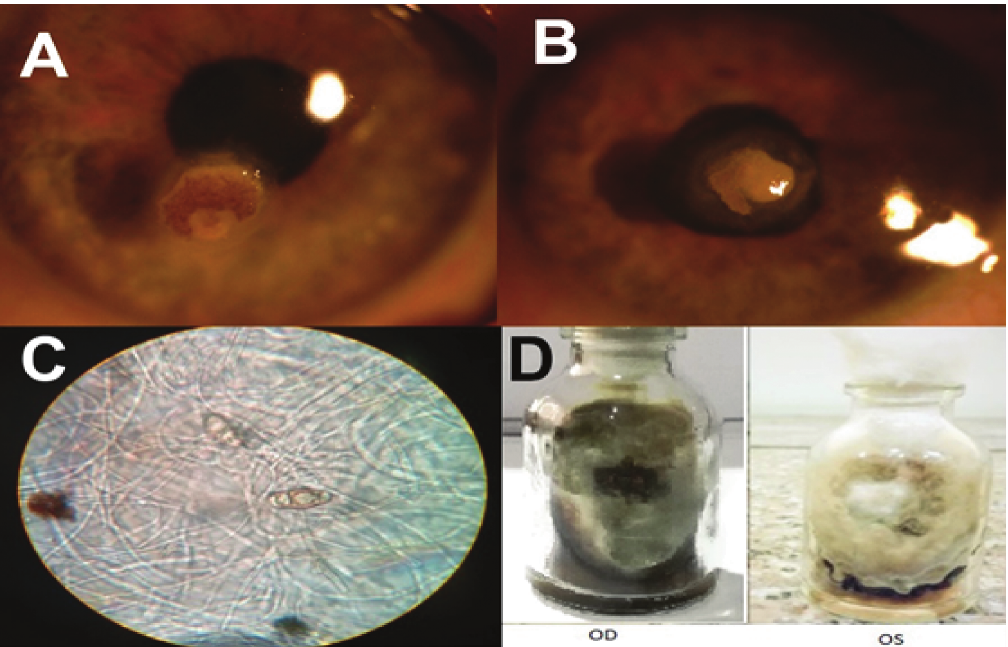
Figure 1. Bilateral Curvularia Keratitis. (A & B): Slit lamp photograph of right and left eye in diffuse elimination showing 2 × 2 mm of epithelial defect with overlying pigmanted plague. (C): 10% KOH direct mount preparation from plate of both eyes (40 × ) showing pigmented multiple cell conidia. (D) SDA siant culture showing woolly greyish black